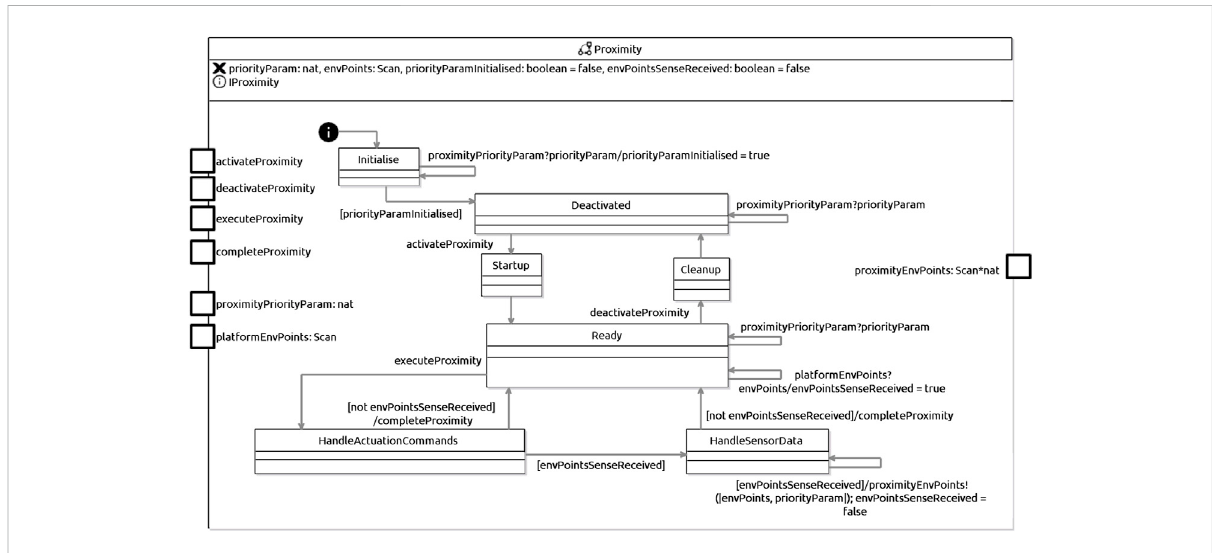
FIGURE 7 RoboChart state machine for Proximity D-Skill.